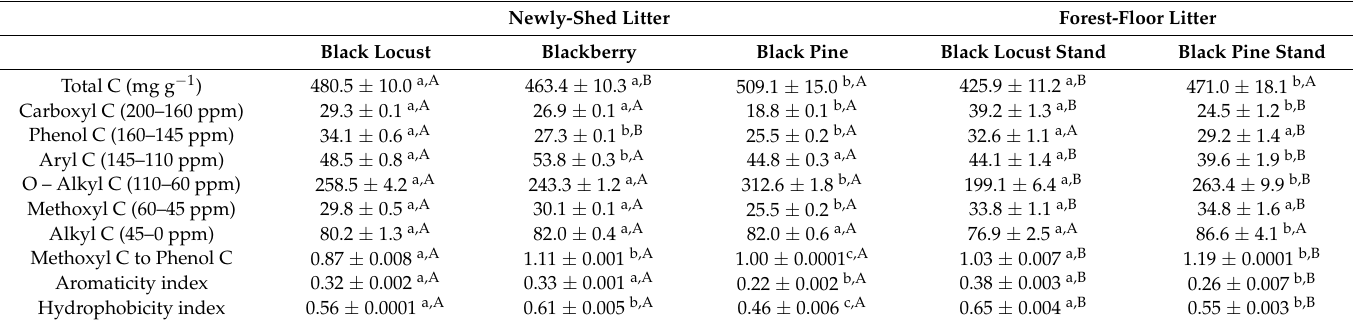
Values are means ± standard error (N = 10 for newly-shed litter; N = 20 for forest floor, and mineral soil 0–5 cm depth). Different lowercase letters indicate statistically significant differences between litter species (One-way ANOVA, p < 0.05) or between forest stands ( t -test, p < 0.05). § Source: De Marco et al., [12]; §§ Source: De Marco et al., [13]. Table 2. Mass of C fractions ( 13 C-NMR data), Methoxyl C-to-Phenol C ratio, Aromaticity (Phenol C + Aryl-C -to- O-Alkyl C) and Hydrophobicity (Aryl-C + Phenol C + Alkyl-C –to- Carboxyl-C + O-Alkyl C) indices in newly-shed litter and forest-floor litter from two paired forest stands at Mount Vesuvius. Newly-Shed Litter Forest-Floor Litter Black Locust Blackberry Black Pine Black Locust